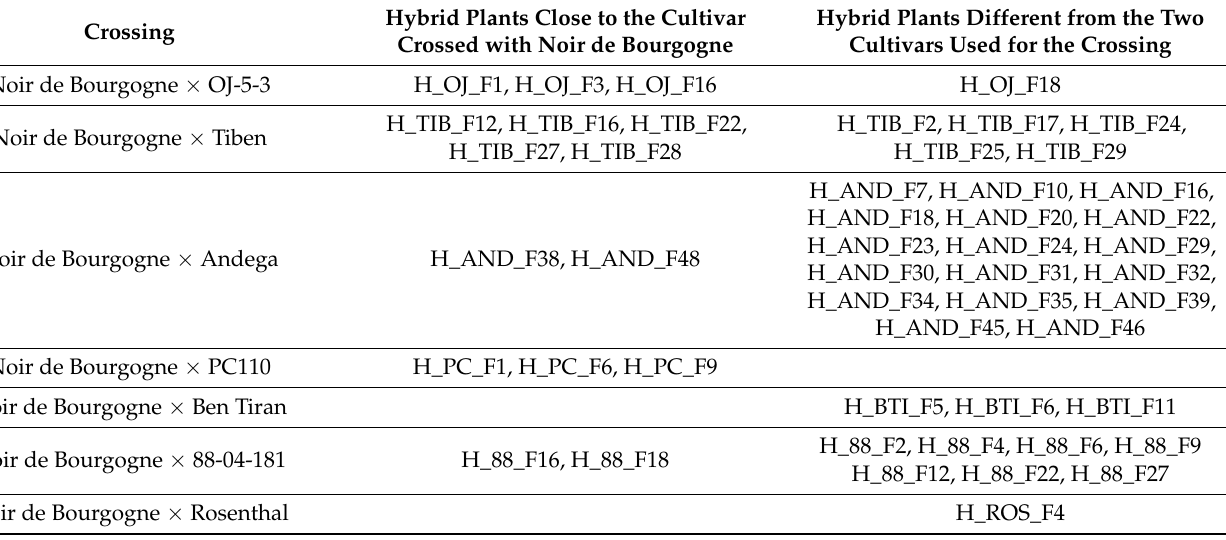
Table 1. Dispersion of the profiles in volatile compounds among the different hybrids. Hybrid Plants Close to the Cultivar Crossing Crossed with Noir de Bourgogne